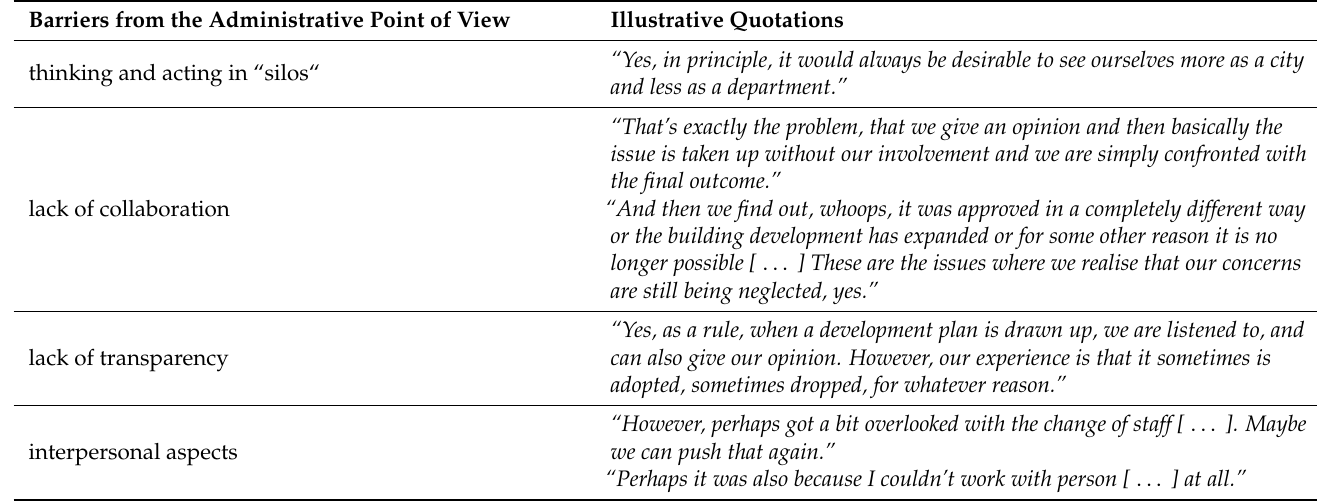
Table 4. Barriers linked to collaborative arrangements within and between the city departments from the administrative point of